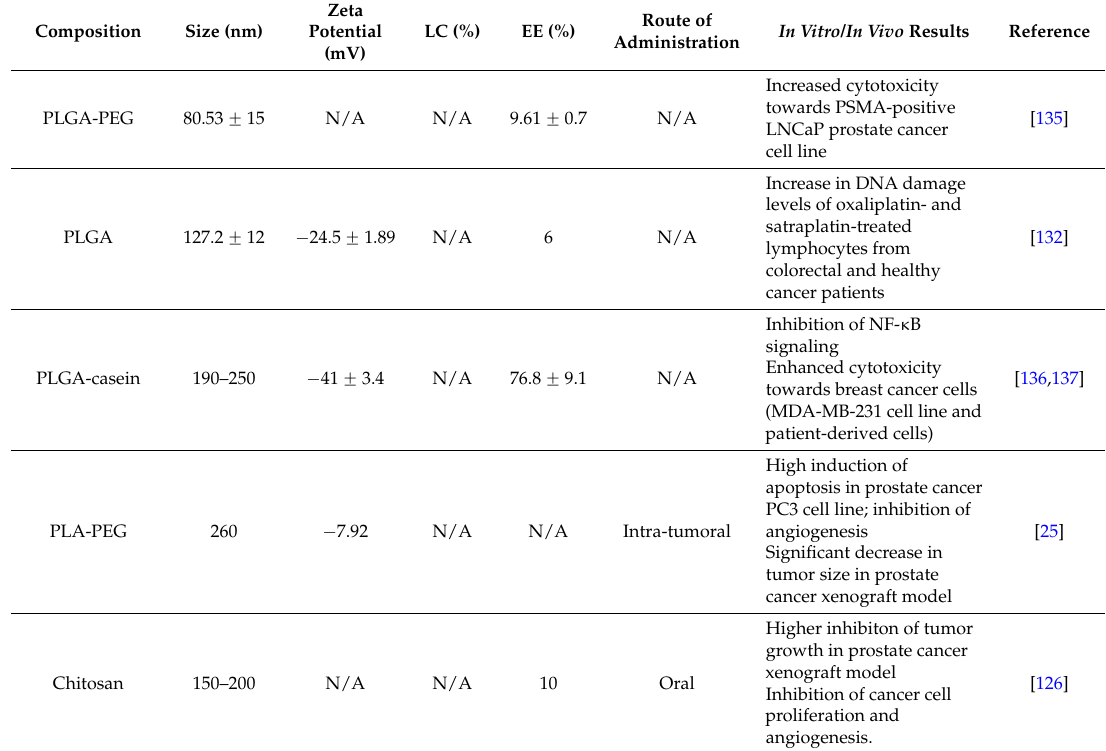
Table 2. Polymeric nanoparticles used as EGCG nanocarriers for cancer